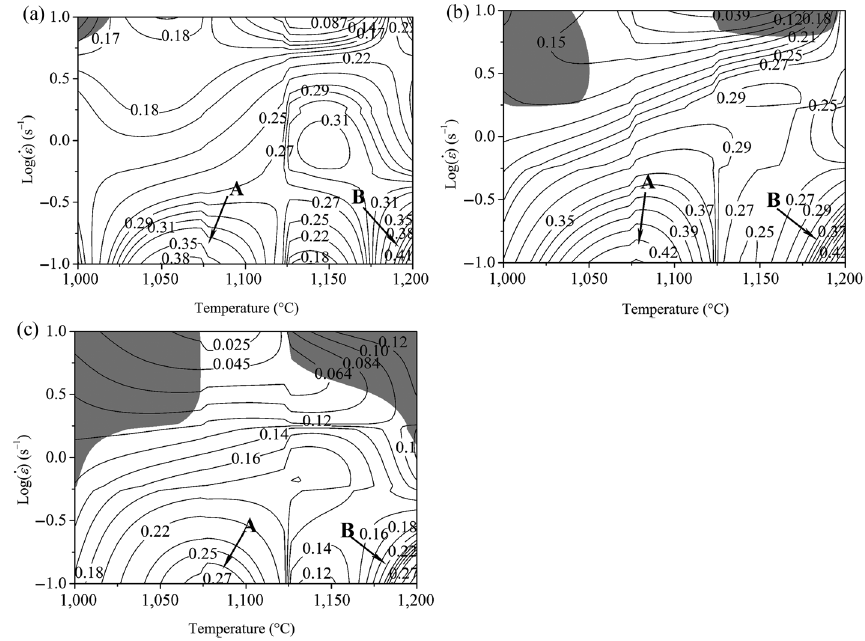
Figure 13: Processing maps of AISI 410 steel with the different true strains: (a) ε = 0.3; (b) ε = 0.6; and (c) ε =